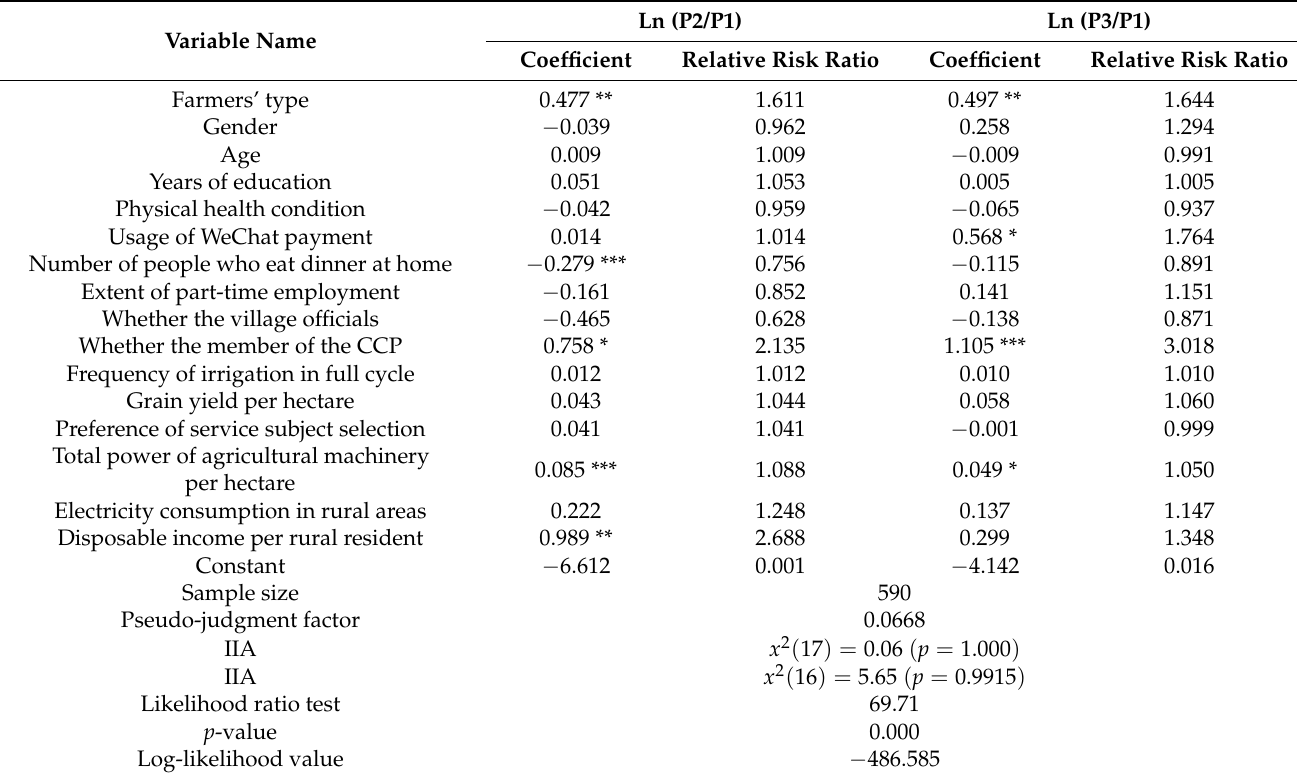
Table 5. Estimation results of mlogit model of willingness to adjust agricultural production